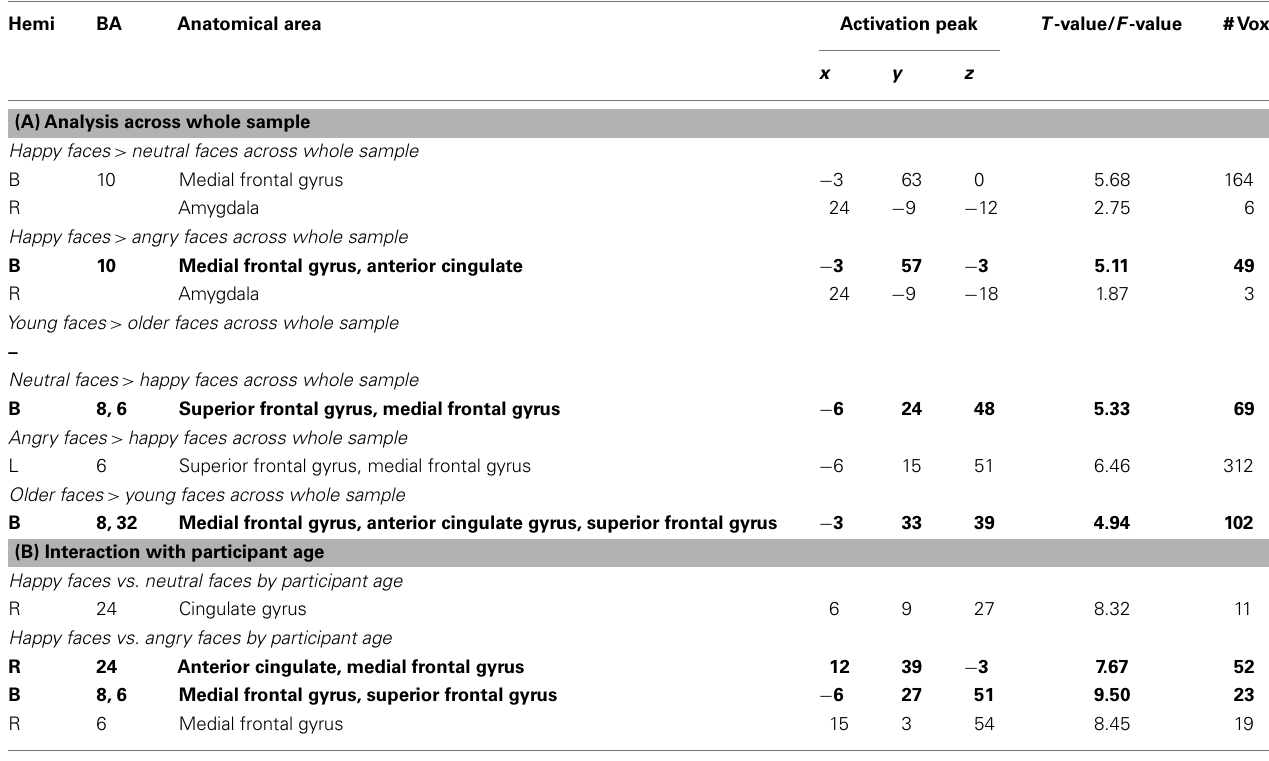
Table 4 | Results of ROI analyses: activity in mPFC and amygdala during facial expression identification to happy relative to neutral or angry and young relative to older faces (across whole sample and in interaction with participant